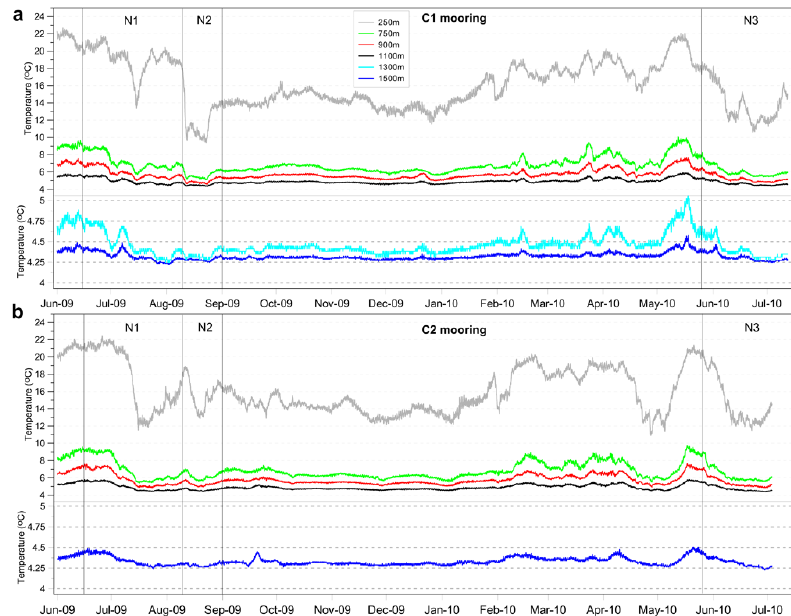
Figure 6. Sea temperature ( ◦ C) temporal evolution at several depths (250, 750, 900, 1100, 1300, and 1500m) from (a) C1 and (b) C2 moorings (Fig. 1) from June 2009 to mid-July 2010. The 1300 and 1500m time series are plotted with a different y axis for clarity reasons. The LCFE N1, N2, and N3 periods are indicated with black solid vertical